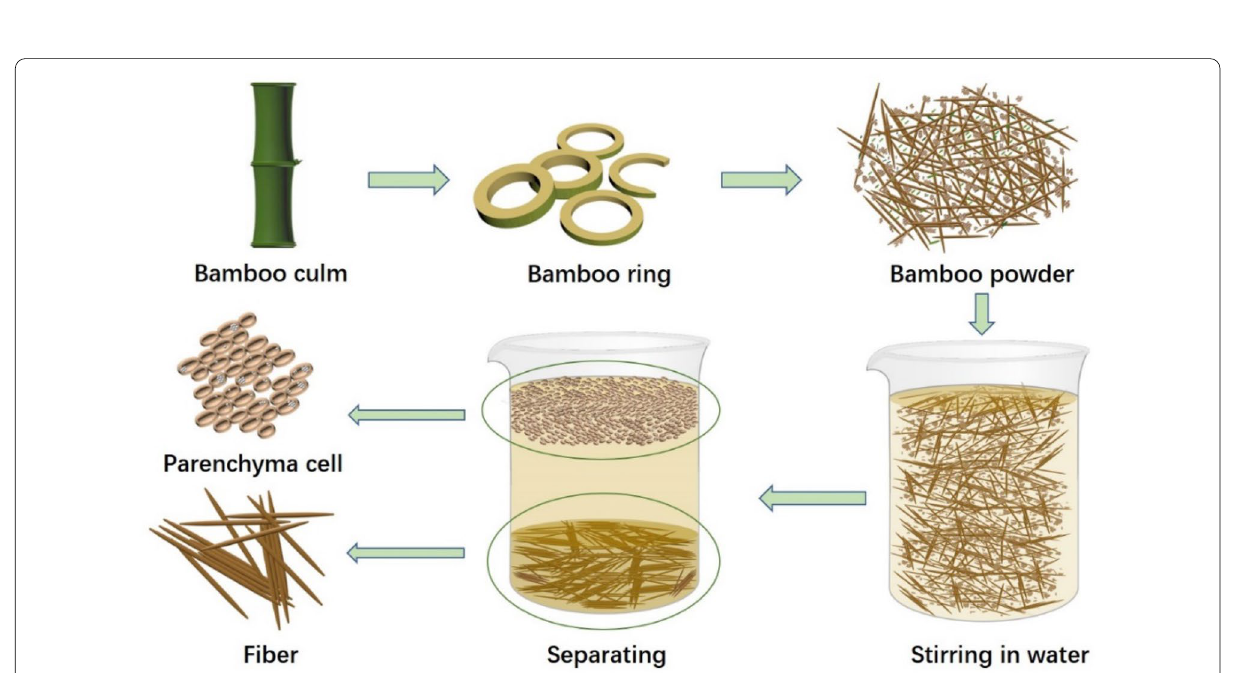
Fig. 1 The separation of parenchyma cells and fibers from bamboo